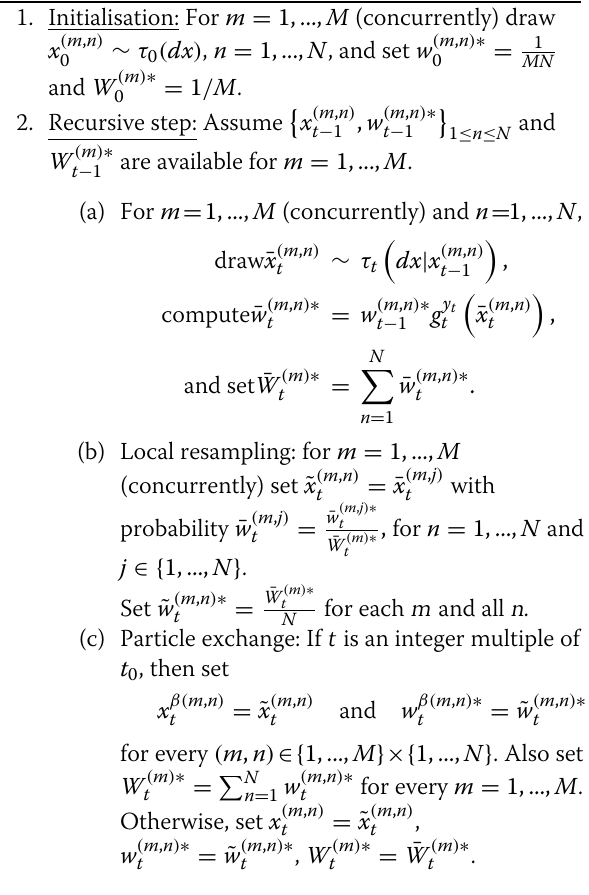
Algorithm 2: DRNA-based parallel PFs with M sub- sets, N particles per subset and periodic particle exchanges every t 0 time